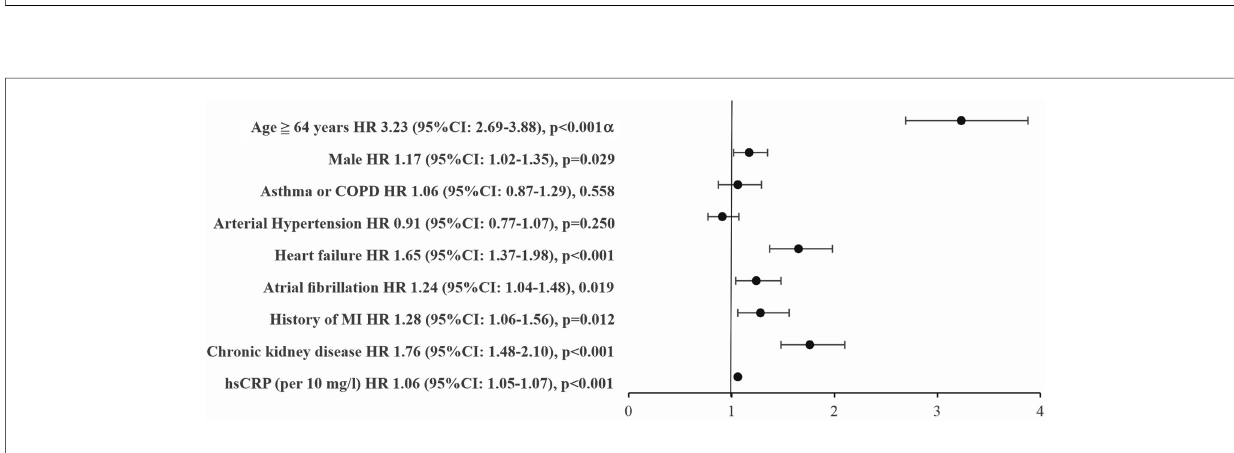
FIGURE 2 Cox regression analysis: independent predictors of 30-day mortality (whole study group; N =4998). α - median for age in whole study group was 64 years; abbreviations: CI, con fi dence interval; COPD, chronic obstructive pulmonary disease; HR, hazard ratio; hsCRP, high-sensitivity C reactive protein; MI, myocardial